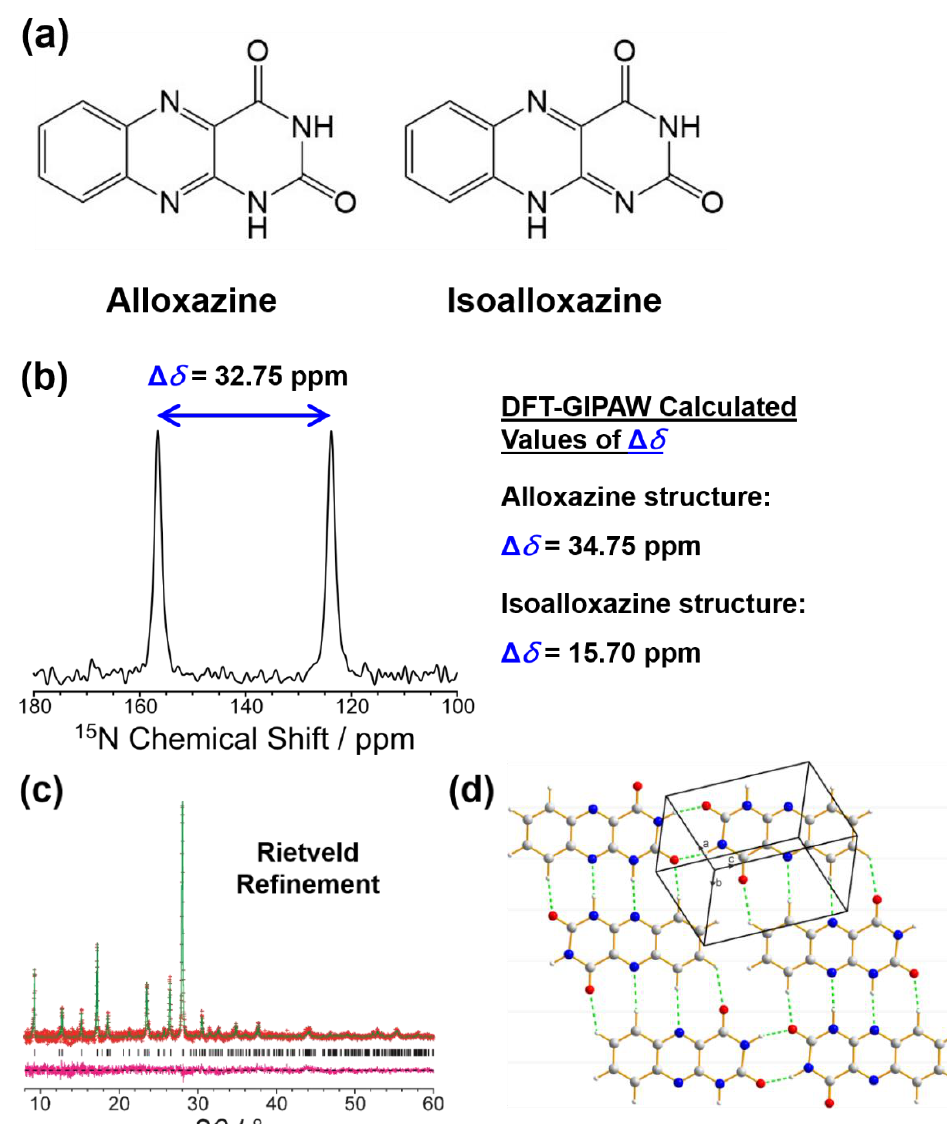
Figure 5. ( a ) The alloxazine and isoalloxazine tautomers, and ( b ) experimental high-resolution solid-state 15 N NMR data, which provides strong evidence that the crystal structure of this material contains the alloxazine tautomer. ( c ) Final Rietveld refinement of the powder XRD data for the alloxazine tautomer, showing a very good quality of fit, and ( d ) the final refined crystal structure containing the alloxazine tautomer.